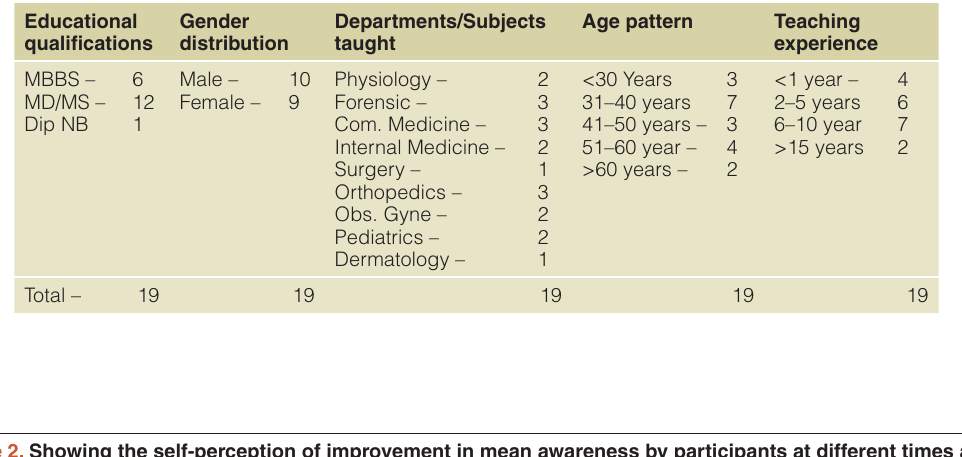
% score before exposure to TA training